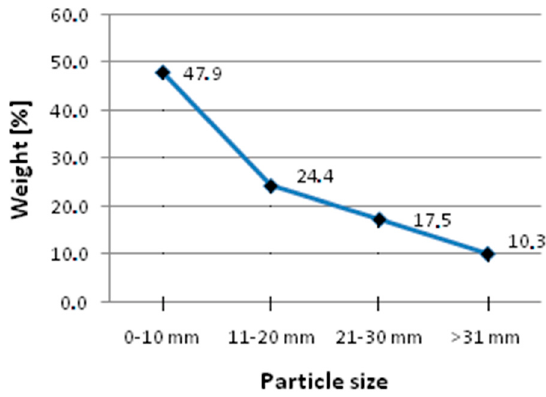
Figure 1. Grading curve of the hemp shives used in the study.